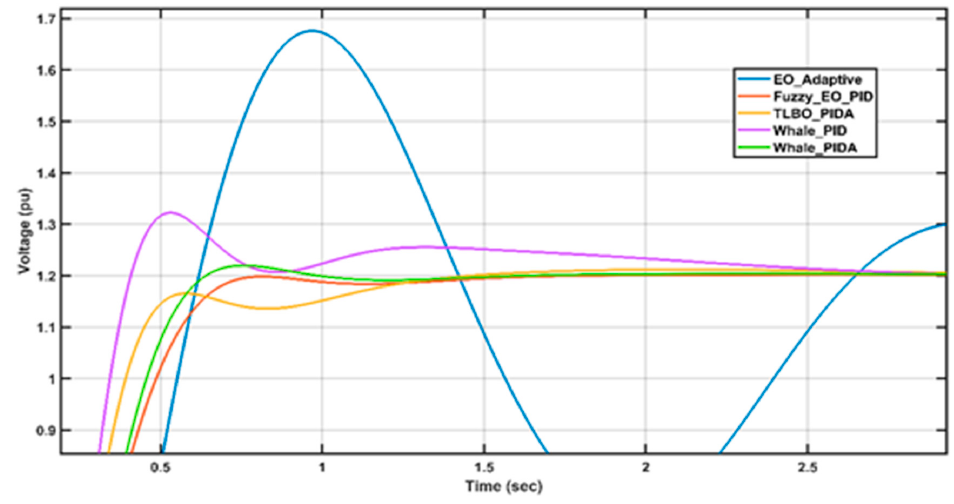
Figure 13. Focusing on 1.2 pu step voltage reference case.